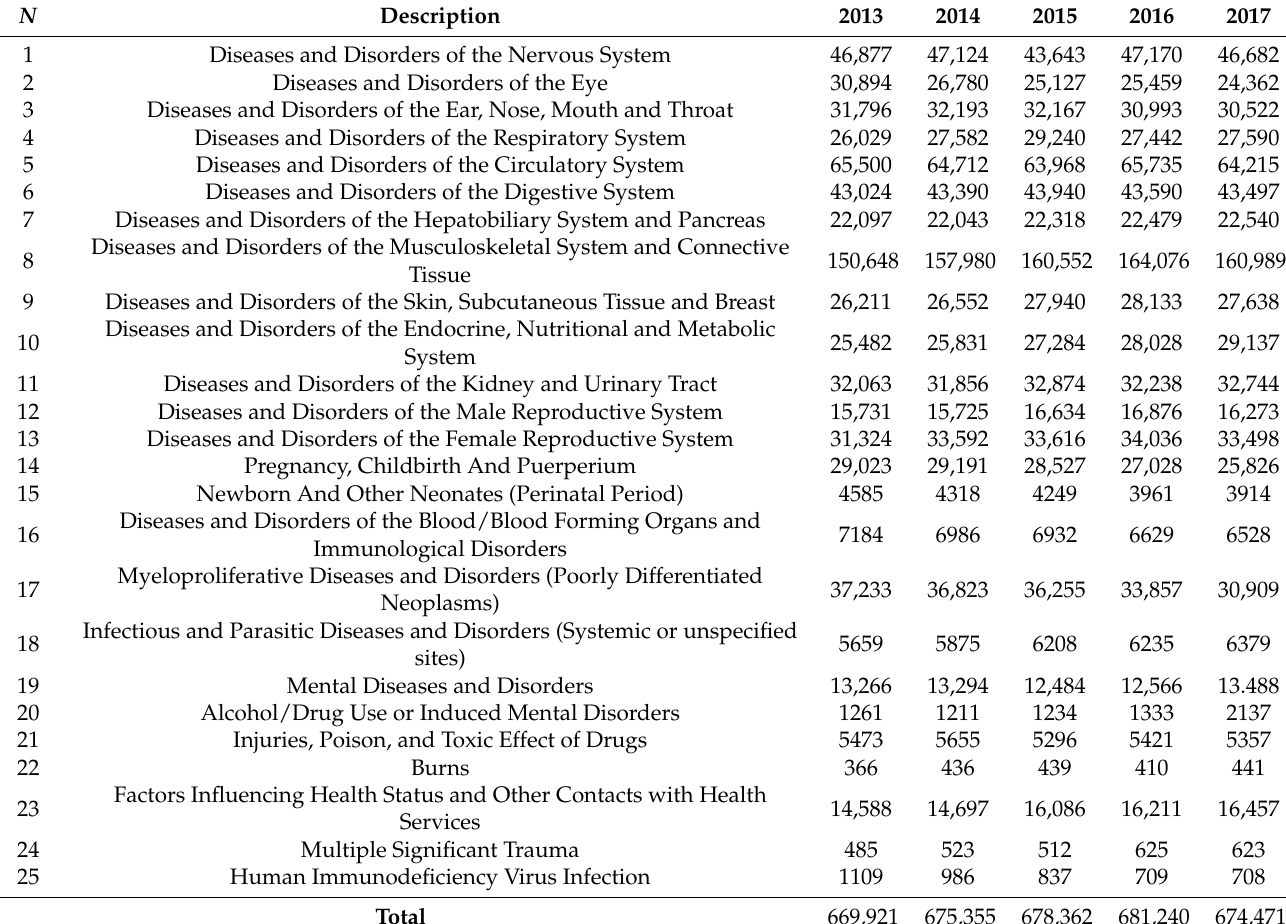
Table 3. Hospitalizations in mobility, divided for MDCs,